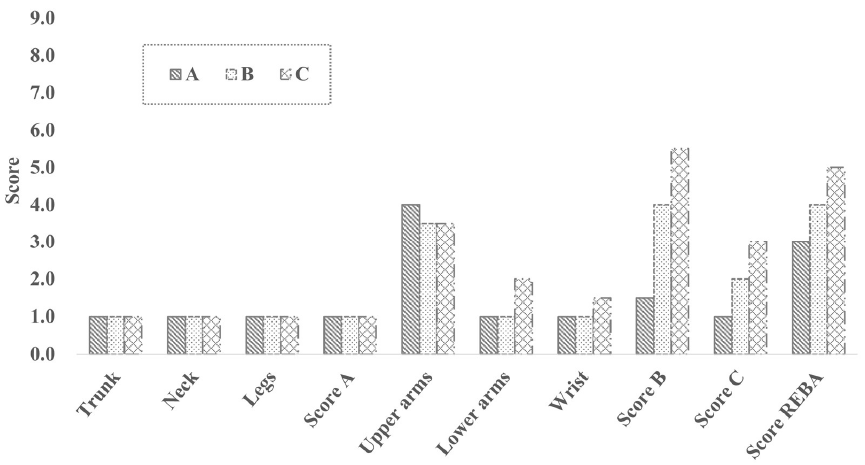
Figure 23. Precision evaluation results of drilling machine working